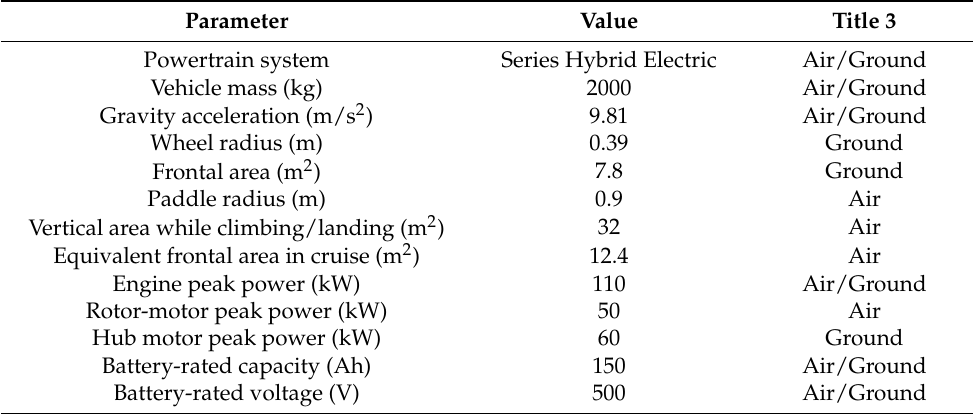
Table 1. Basic HEAGV